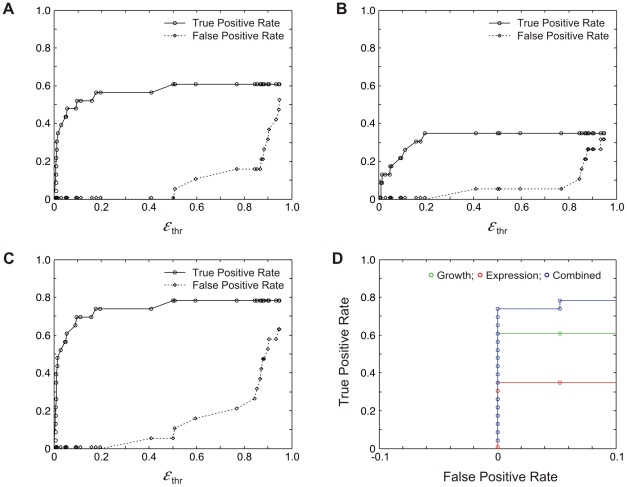
Analyses of true (TPR) and false positive rates (FPR) for inference of causal relationships among GAL genes.(A, B) TPR (circles) and FPR (diamonds) for analysis of fitness and expression, respectively. (C) TPR (circles) and FPR (diamonds) for combined analyses. (D) Receiver operating characteristic curves for fitness, expression and combined analyses.